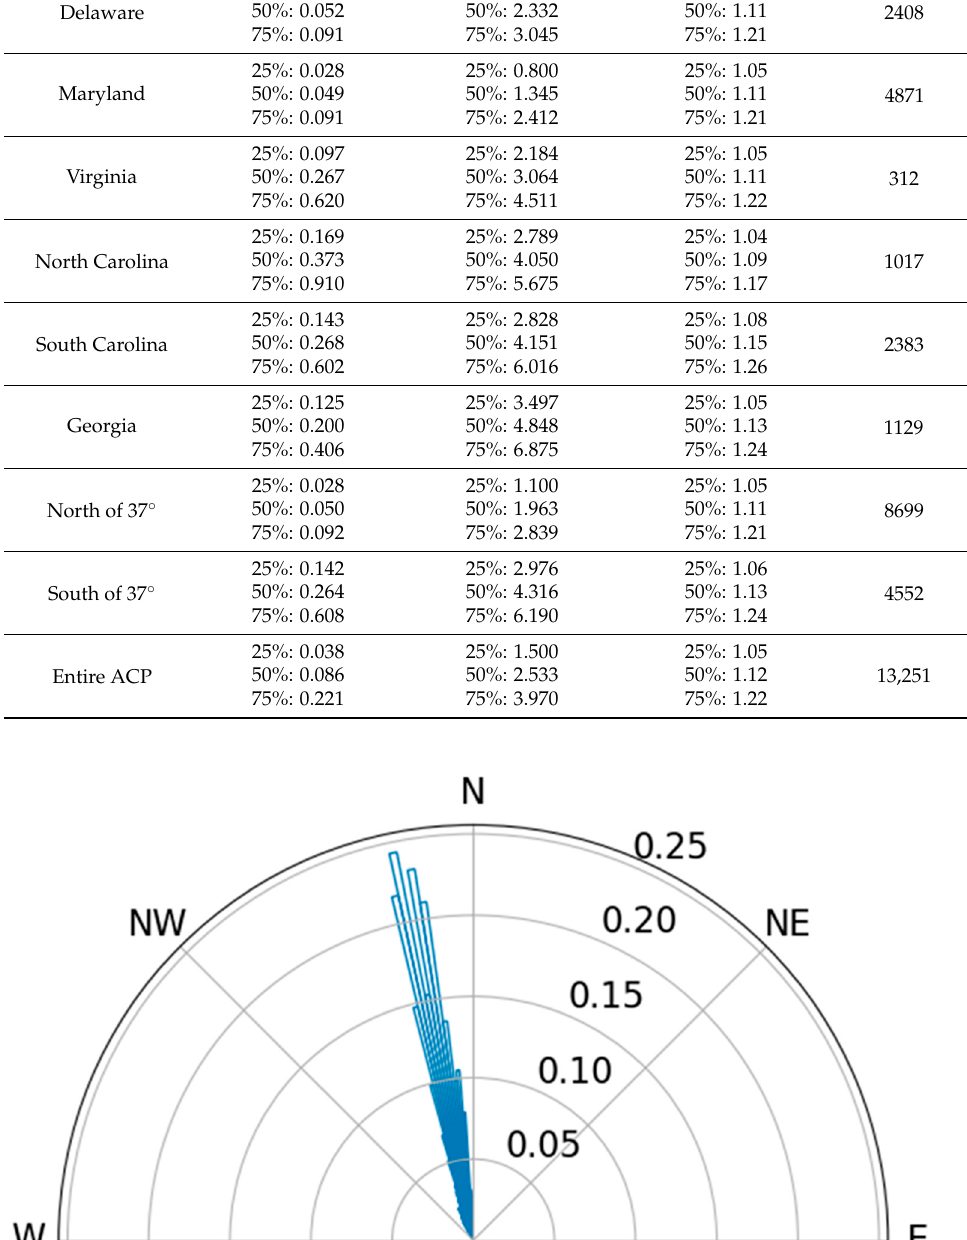
Figure 15. Polar plot of kernel density estimation of Carolina Bay detection major axis orientations.